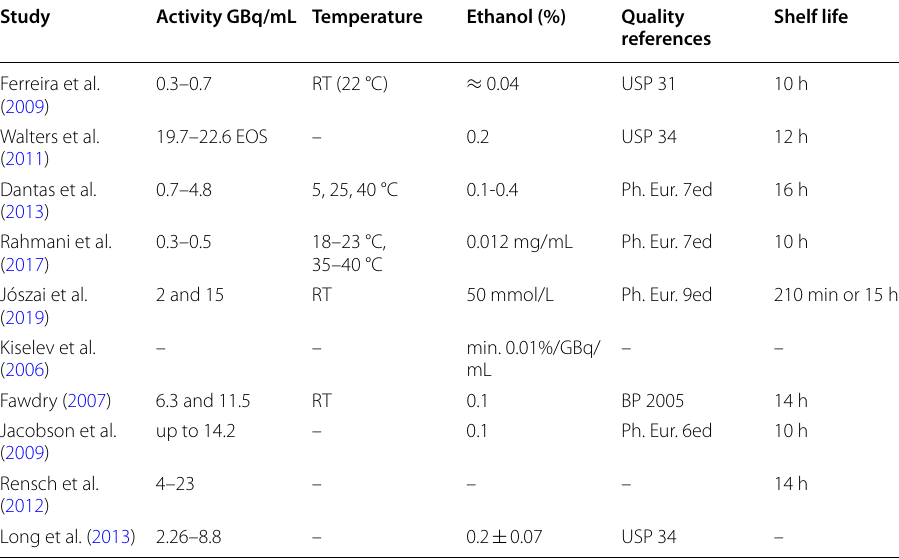
Table 3 Overview of stability studies with activity investigated, temperature, amount of ethanol, quality references and shelf